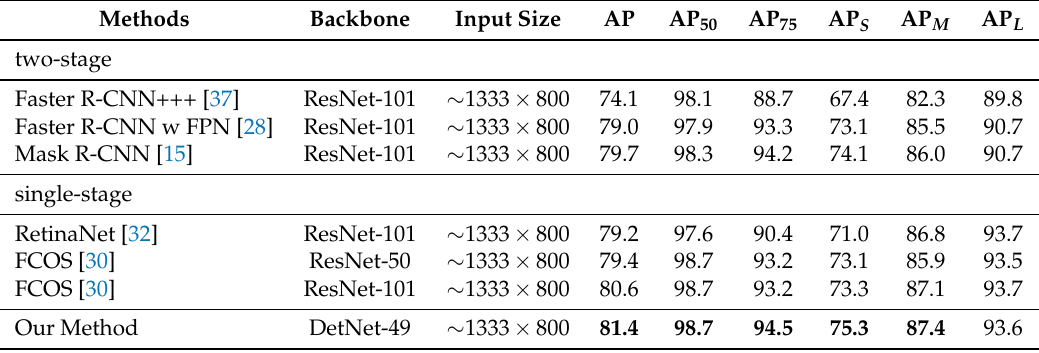
Table 5. Detection Results (%) of Different Methods for the UAVDT Dataset. The bold numbers represent the best